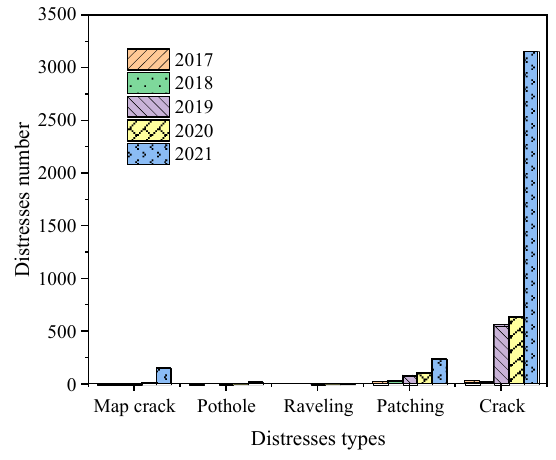
Figure 11. Distress conditions of XHMB pavement.